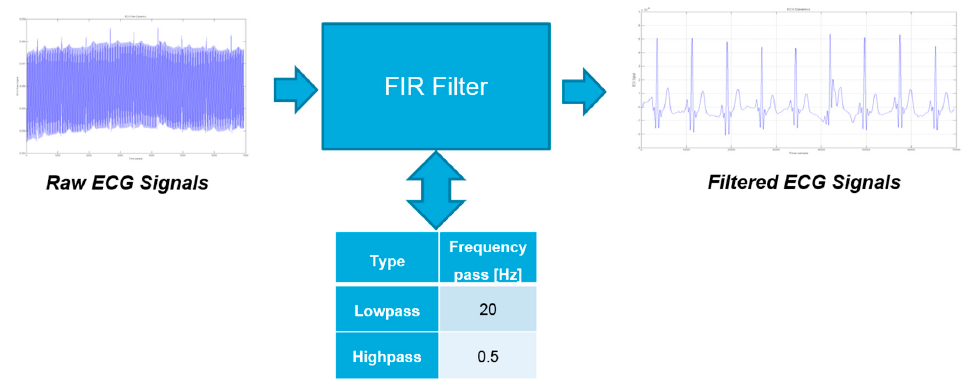
Figure 14. The ECG filter system (FIR).